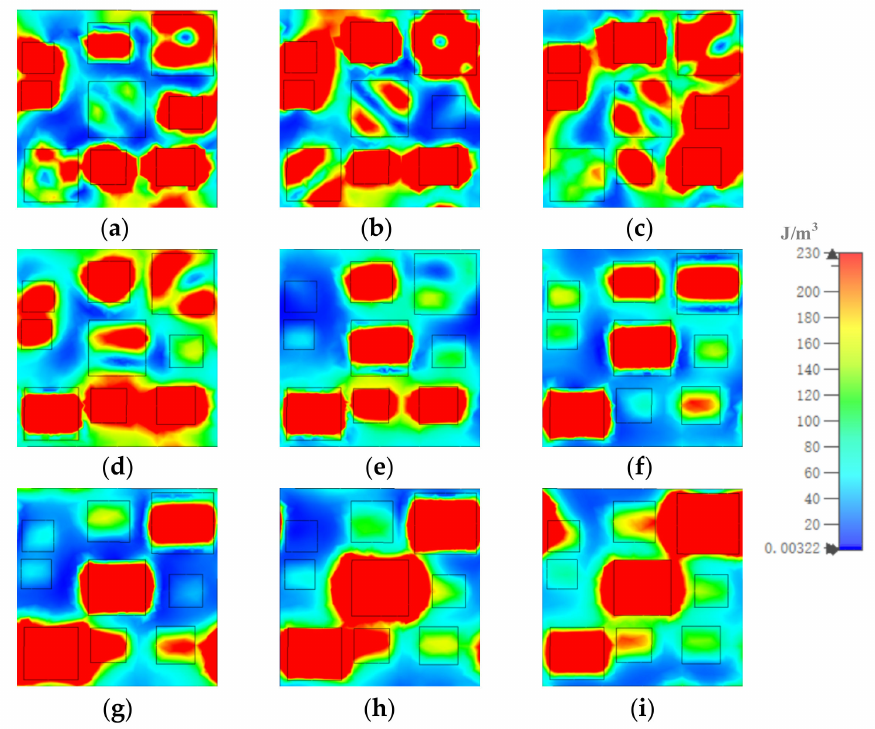
Figure 8. The distribution of magnetic field energy in gold substrate at ( a ) 8.5, ( b ) 9.13, ( c )